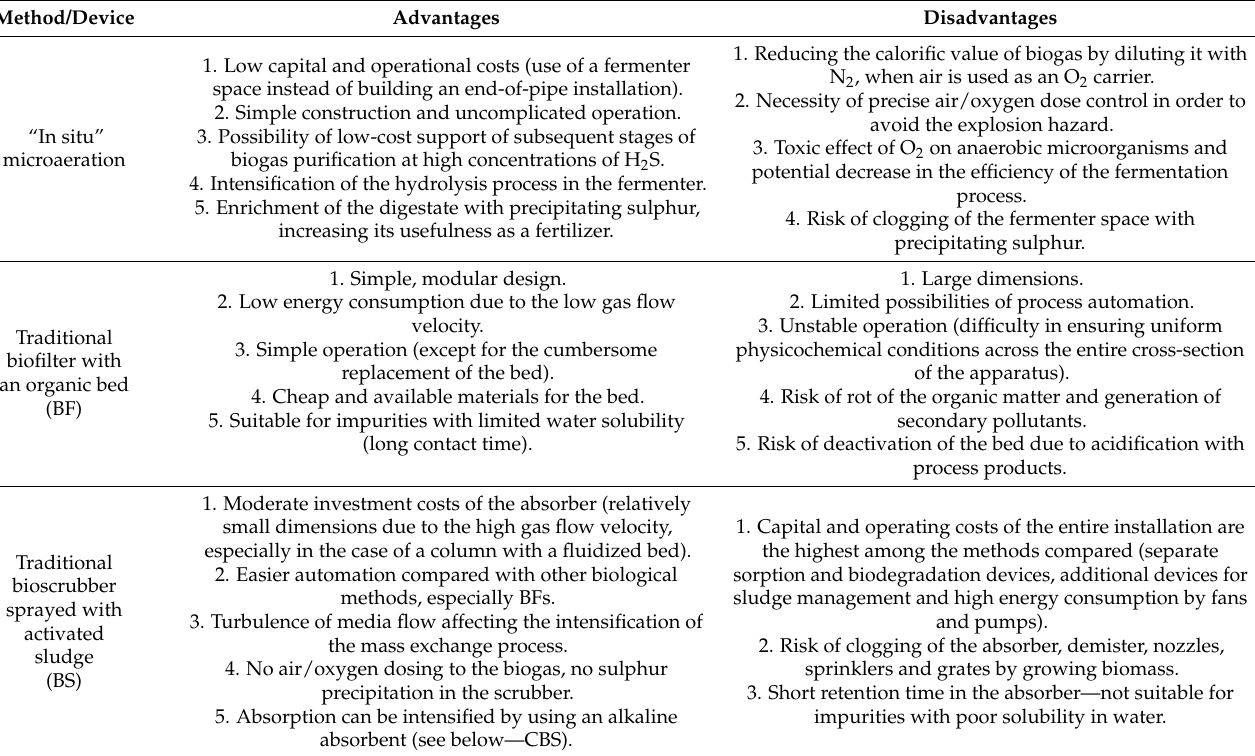
Table 2. Comparison of the potential biological methods and devices for biogas